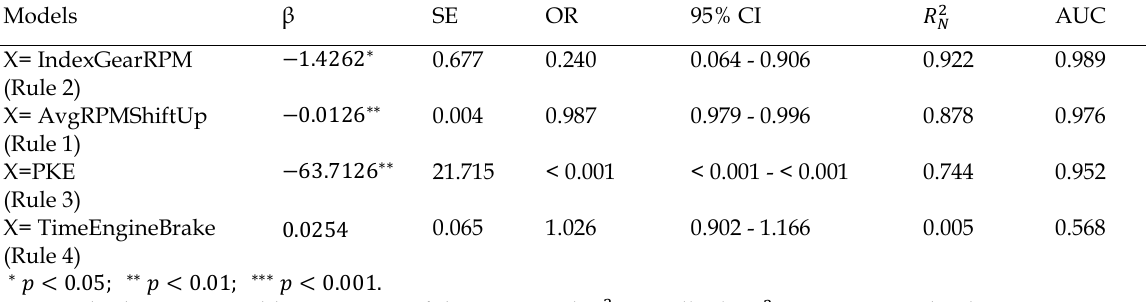
Table 4. Experiment 2: logistic regression models with each of the four indicators associated with the main rules of eco-driving and ranked in descending order of implementation of each driving